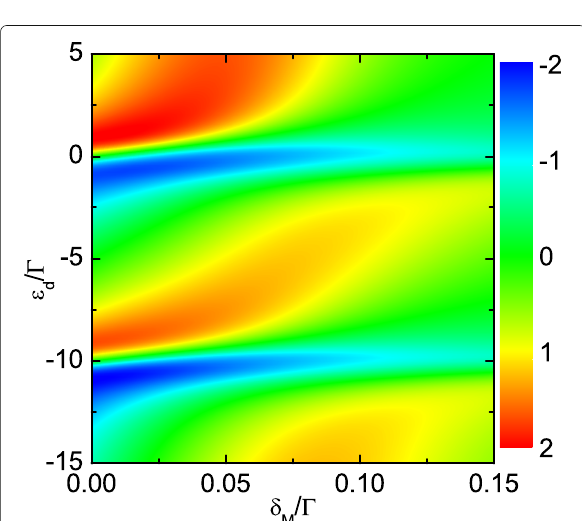
Fig. 6 Counter plot of the thermopower (color online). Counter plot of the thermopower as a function of ε d and λ 2 for λ 1 = 0.2 (cid:6) . Other parameters are the same as those of Fig.